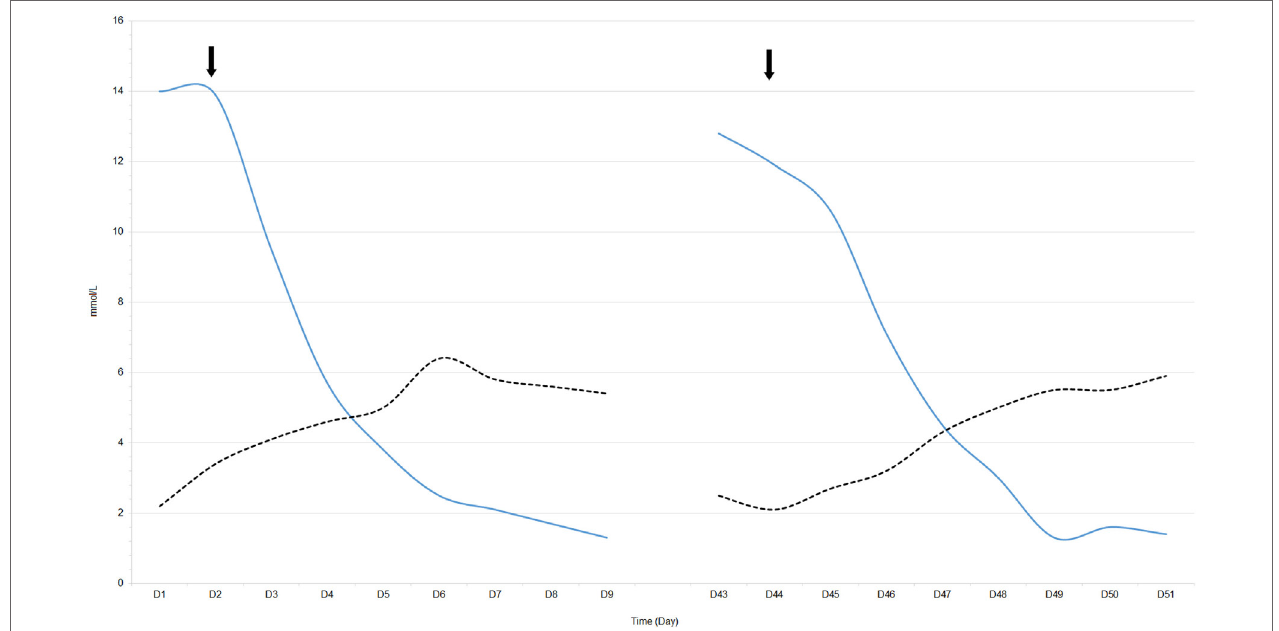
FIgURe 1 | Blood lactate and glucose levels following chemotherapy initiation in our patient at admission (D1) and after relapse (D43). ↓ Chemotherapy administration, solid line: blood lactate level, dotted line: blood glucose level.